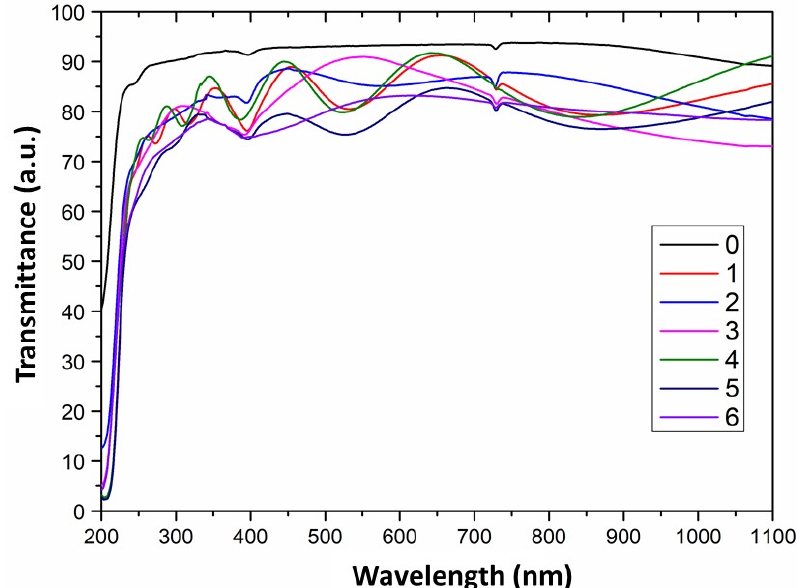
Figure 9. Transmittance spectrum of uncoated quartz glass and covered with ZrO 2 -Sc 2 O 3 layers under various conditions. 0—uncoated quartz glass; 1—with ZrO 2 -Sc 2 O 3 layer synthesised at 600 °C (the content of Sc(tmhd) 3 : 14 mol.%), reduced pressure; 2—with ZrO 2 -Sc 2 O 3 layer synthesised at 600 °C (the content of Sc(tmhd) 3 : 28 mol.%) without air presence, atmospheric pressure; 3—with ZrO 2 -Sc 2 O 3 layer synthesised at 650 °C (the content of Sc(tmhd) 3 : 14 mol.%), atmospheric pressure; 4—with ZrO 2 -Sc 2 O 3 layer synthesised at 650 °C (the content of Sc(tmhd) 3 : 28 mol.%), reduced pressure; 5—with ZrO 2 -Sc 2 O 3 layer synthesised at 700 °C (the content of Sc(tmhd) 3 : 14 mol.%), reduced pressure; 6—with ZrO 2 -Sc 2 O 3 layer synthesised at 700 °C (the content of Sc(tmhd) 3 : 28 mol.%), reduced pressure.